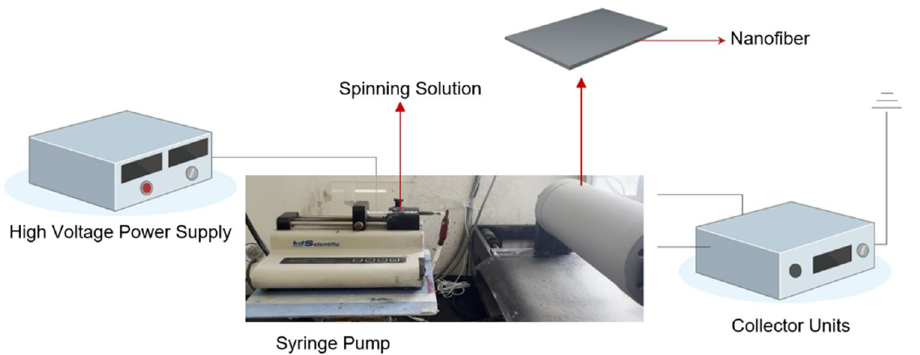
Figure 4. Electrospinning method to increase the dispersion power of the shielding